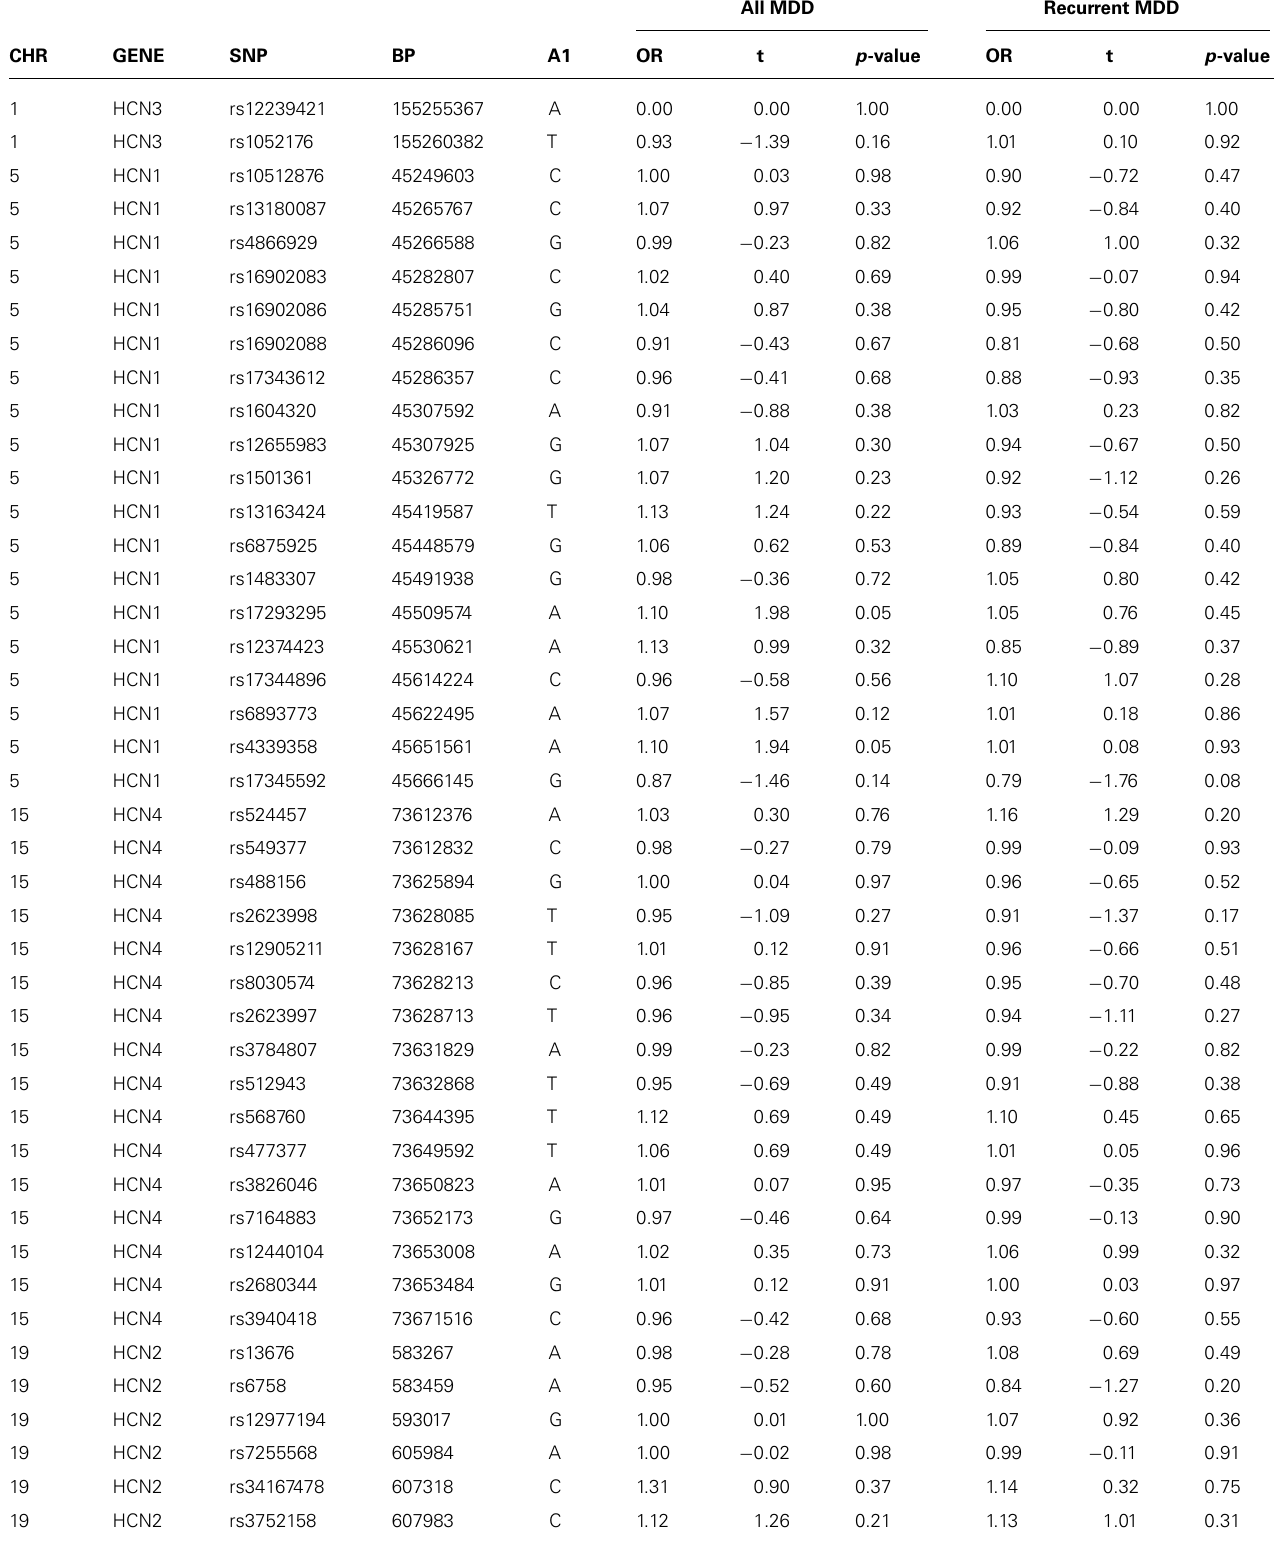
Table 3 |Association of HCN1–4 with